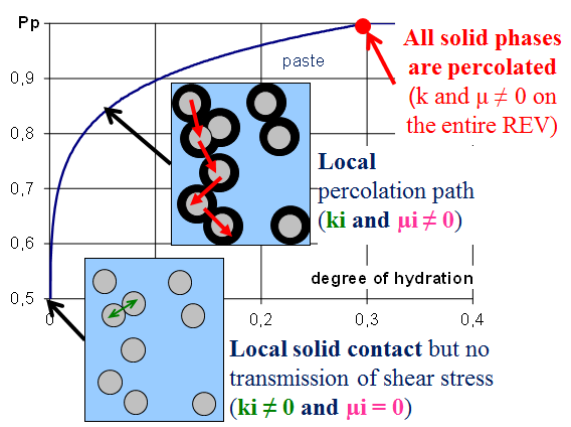
Figure 1. Illustration of percolation function effect on the solid phases of paste (subscript i corresponds to C ‐ S ‐ H, CH, aluminates or